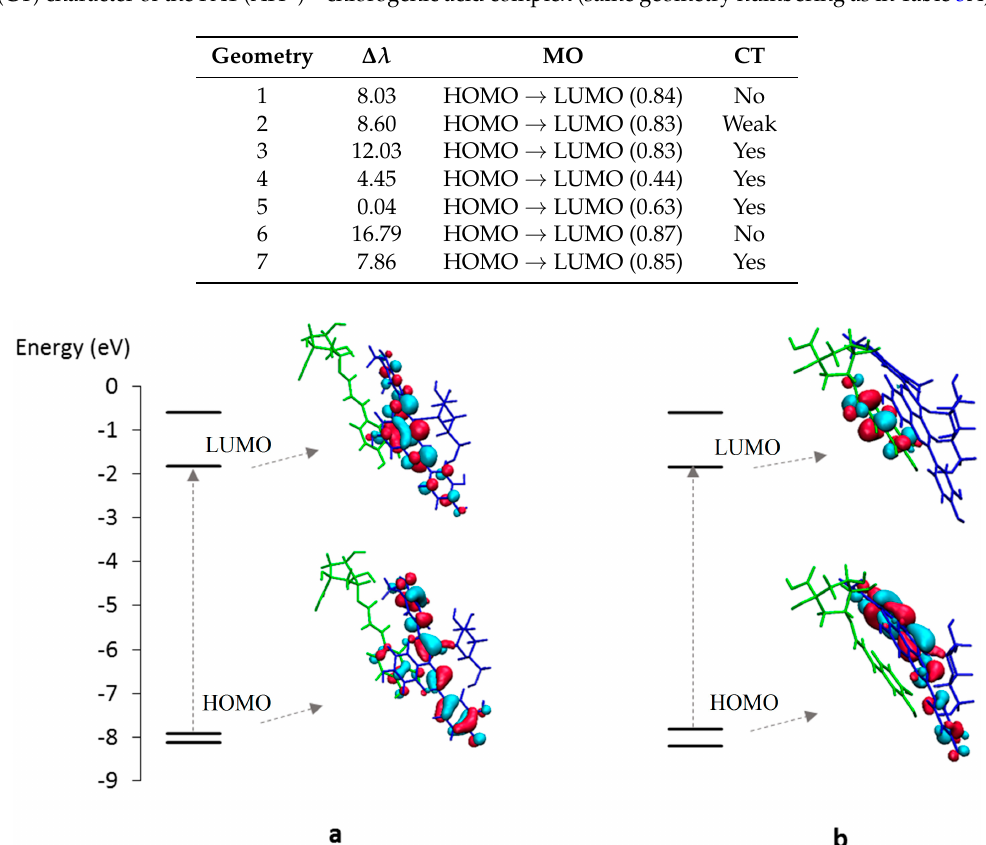
Table 4. Bathochromic shifts Δ λ in nm, molecular orbital (MO) descriptions (%) and charge transfer Table 3A).